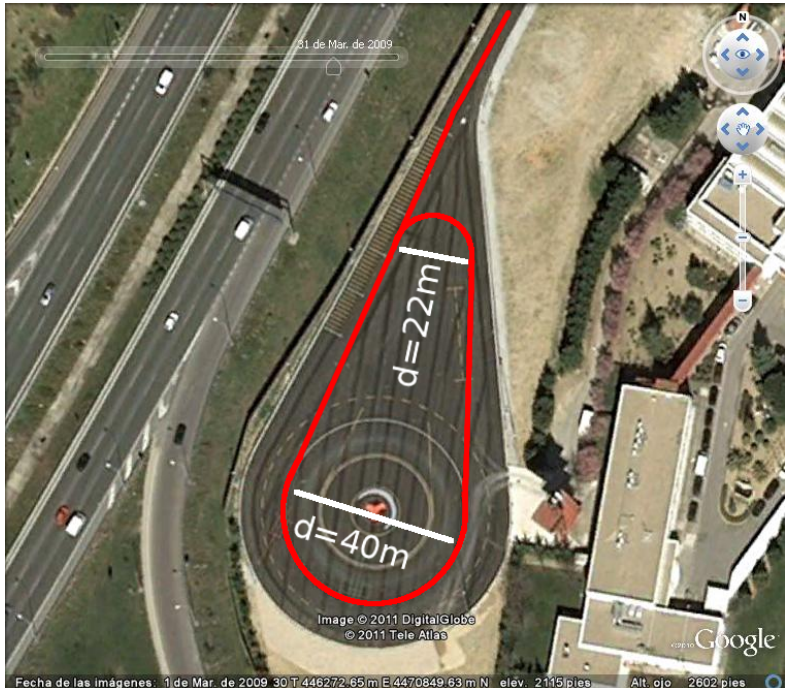
Figure 8. Representation of the circuit at INSIA installations taken with the Google Earth